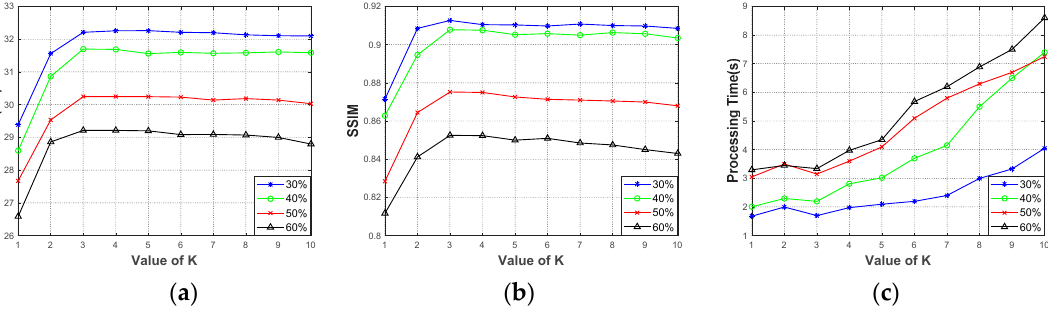
Figure 5. Effects of group gradient parameter K on experimental results: ( a ) PSNR, ( b ) SSIM, and ( c ) processing time.